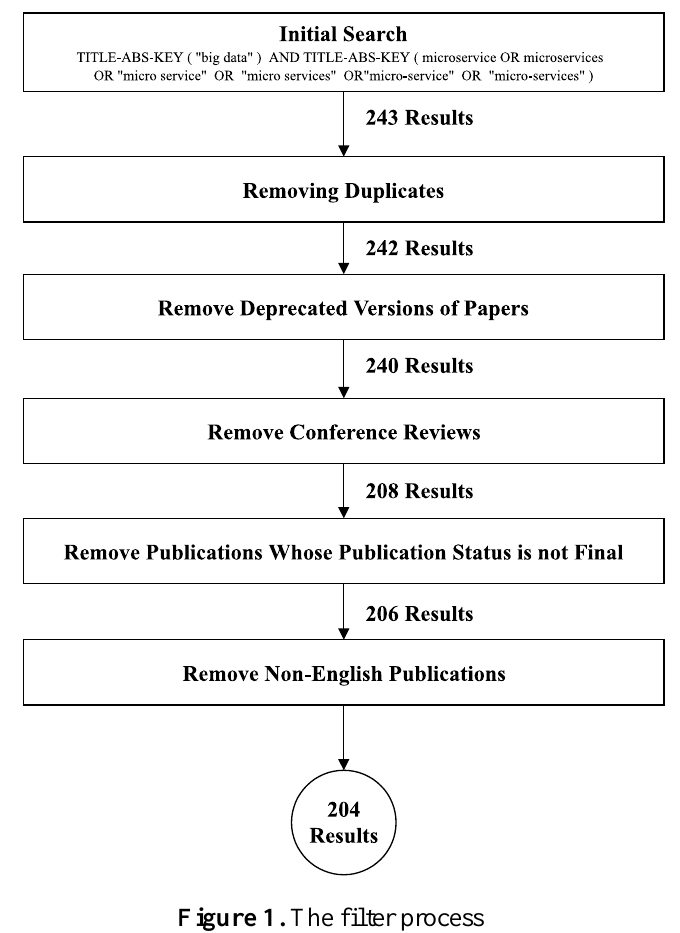
Figure 1. The filter